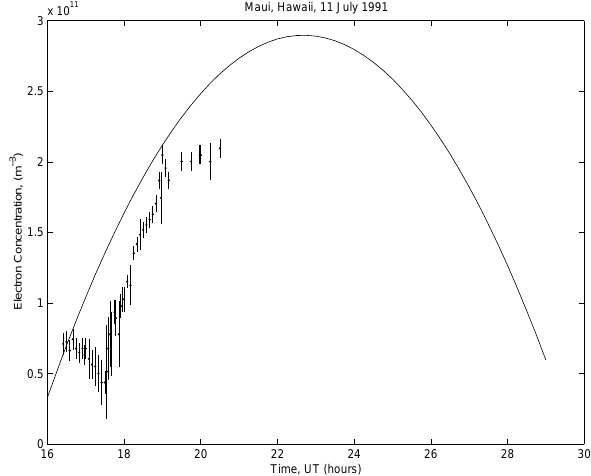
Fig. A5. The variation of the E region peak electron concentration with time during the eclipse of 12 November 1966 at Huancayo, Peru (points). The control day is represented by a polynomial fit to the data from an adjacent day (solid line).